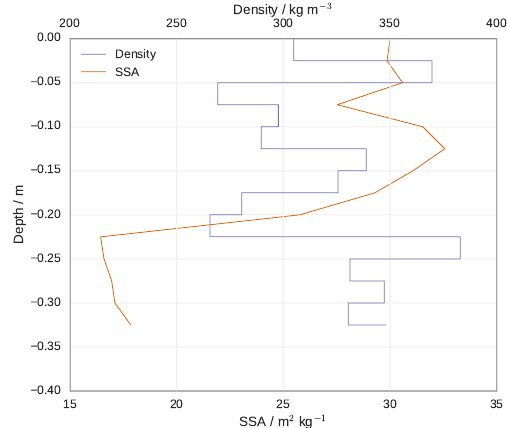
Figure 13. Vertical profiles of SSA (in orange) and density (in blue) measured in the 25kmE_1 snow